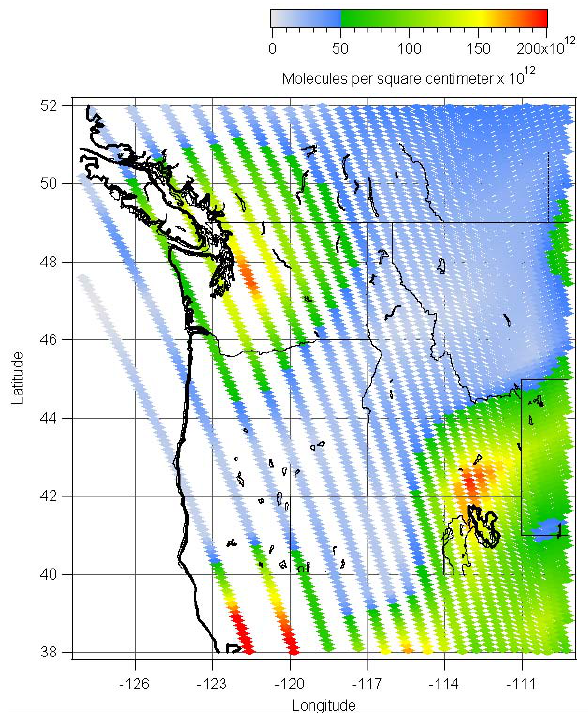
Fig. 2. A sample a priori map of surface layer NO 2 used in DOMINO algorithms, developed with global TM4 simulations at a 3 ◦ × 2 ◦ resolution, plotted as OMI pixel centers for one swath (3 July 2007 shown). This data is provided daily by KNMI, interpo- lated to the daily OMI